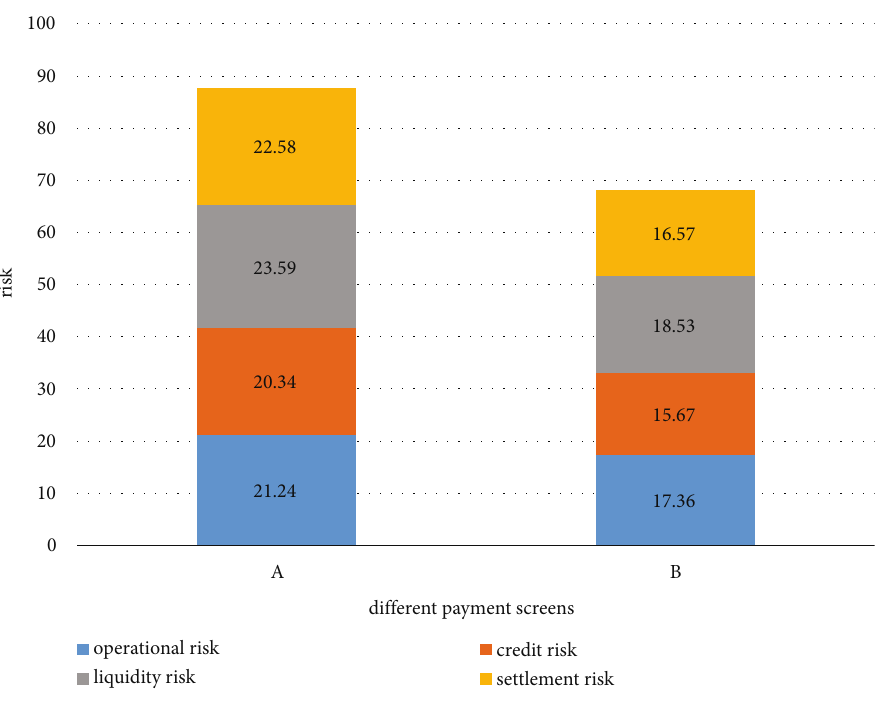
Figure 9: Risk assessment for use of di ff erent payment